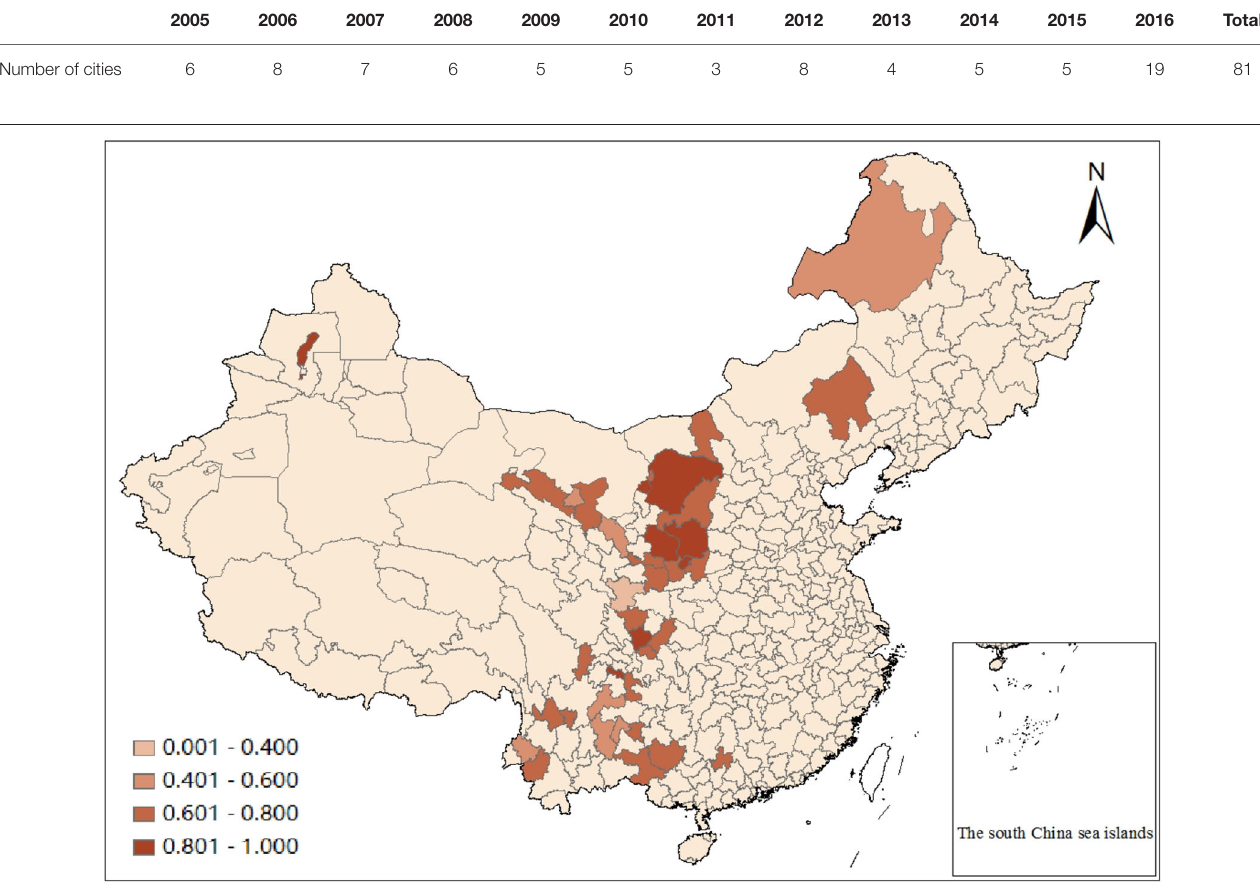
FIGURE 1 | Mean static efficiency of green transformation of resource-based cities in western China from 2005 to